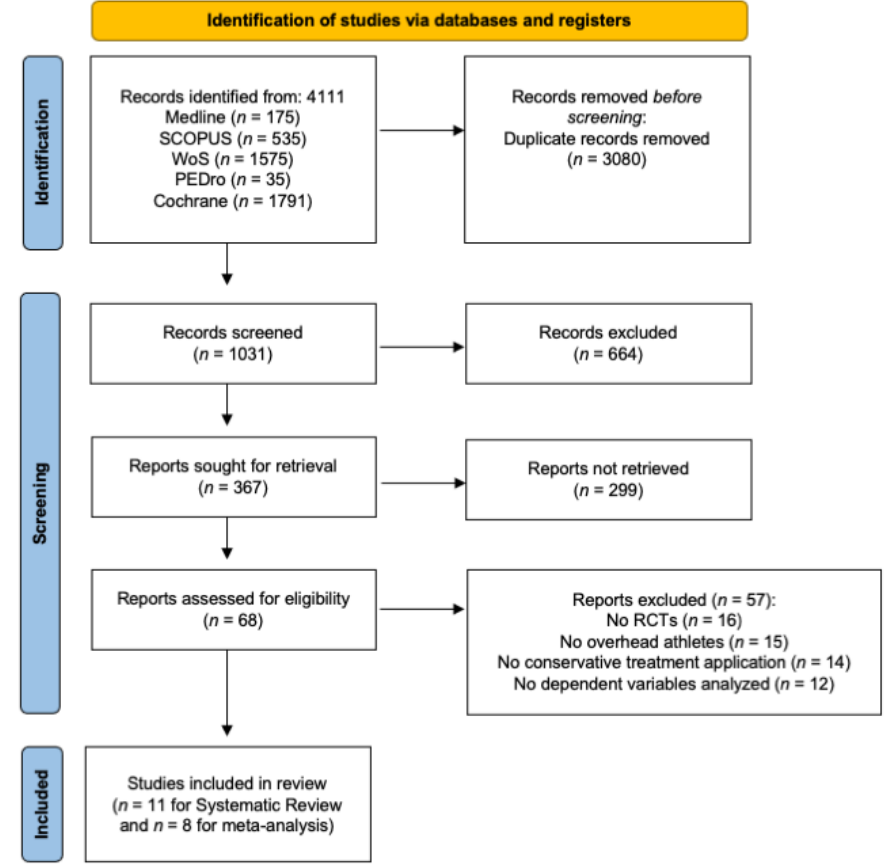
Figure 1. Flowchart diagram of study selection process.